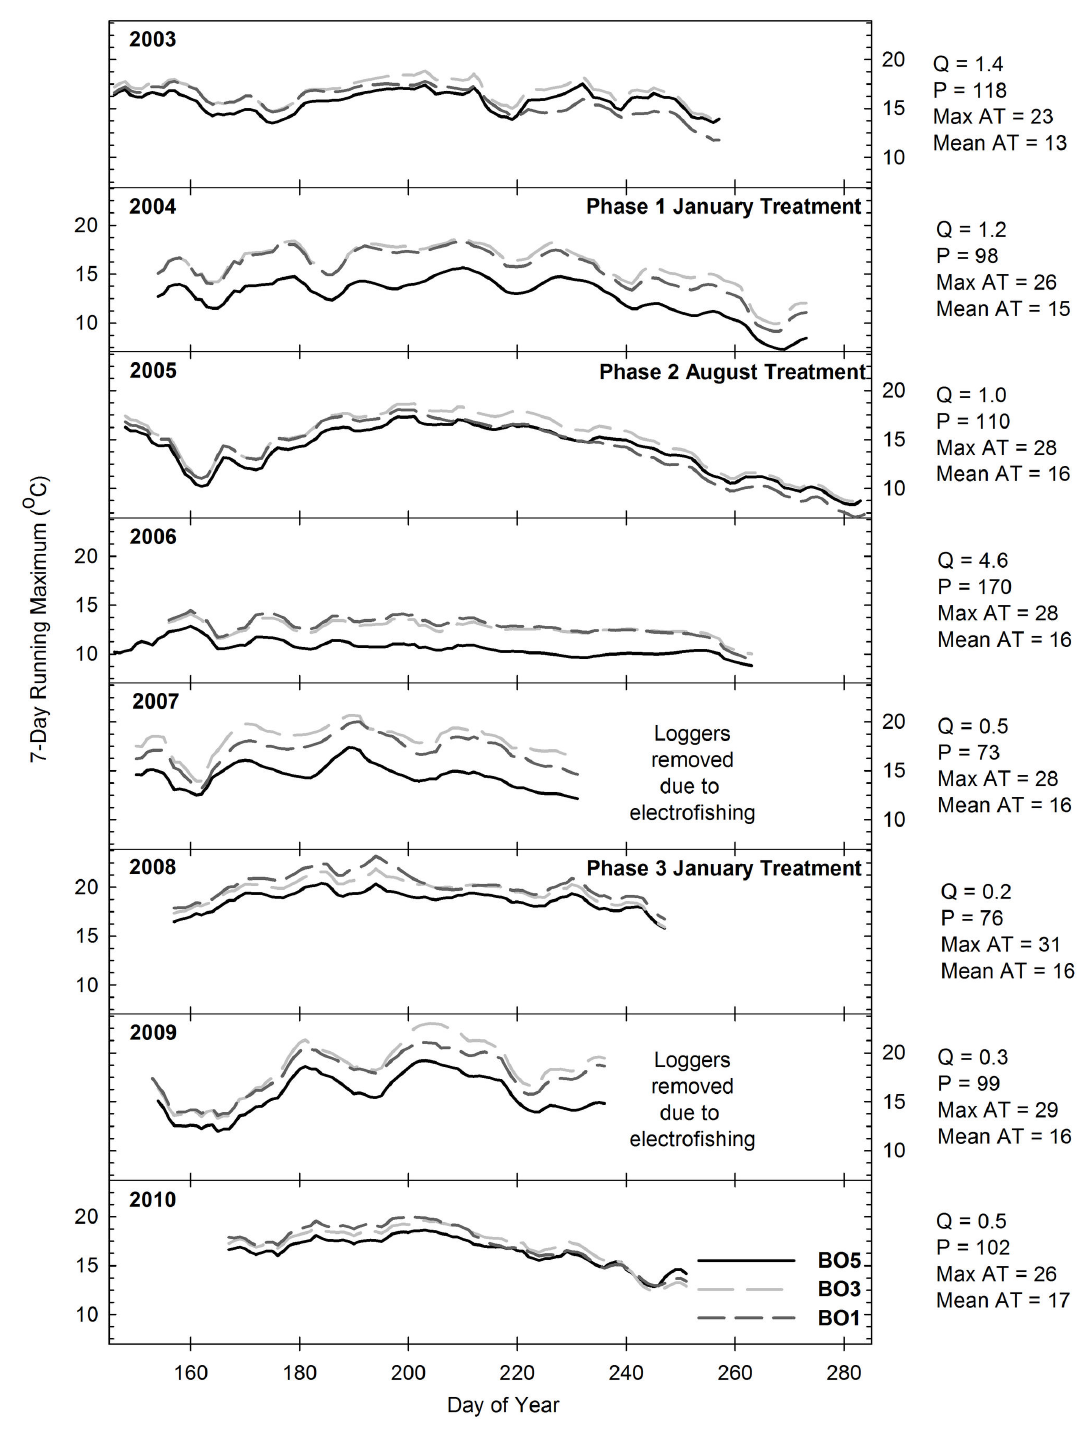
Figure 6. Seven day running average daily maximum water temperature (°C) on Bogard Creek. Station BO5 was located immediately upstream of the areas treated during Phases 1-3. Station BO3 was located immediately downstream of the areas treated during Phase 1, and station BO1 was located immediately downstream of the areas treated during Phases 2 and 3. Q = mean discharge (m 3 min -1 ) from June 15 - August 31, P = percent of mean annual precipitation, Max AT = mean of daily maximum air temperature (°C) from June 15 - August 31, AT = mean of average daily air temperature (°C) from June 15 - August 31. Note: the temperature logger for station BO1 in 2004 was broken, so the 2004 figure shows data collected at station BO2. doi: 10.1371/journal.pone.0084561.g006 PLOS ONE |